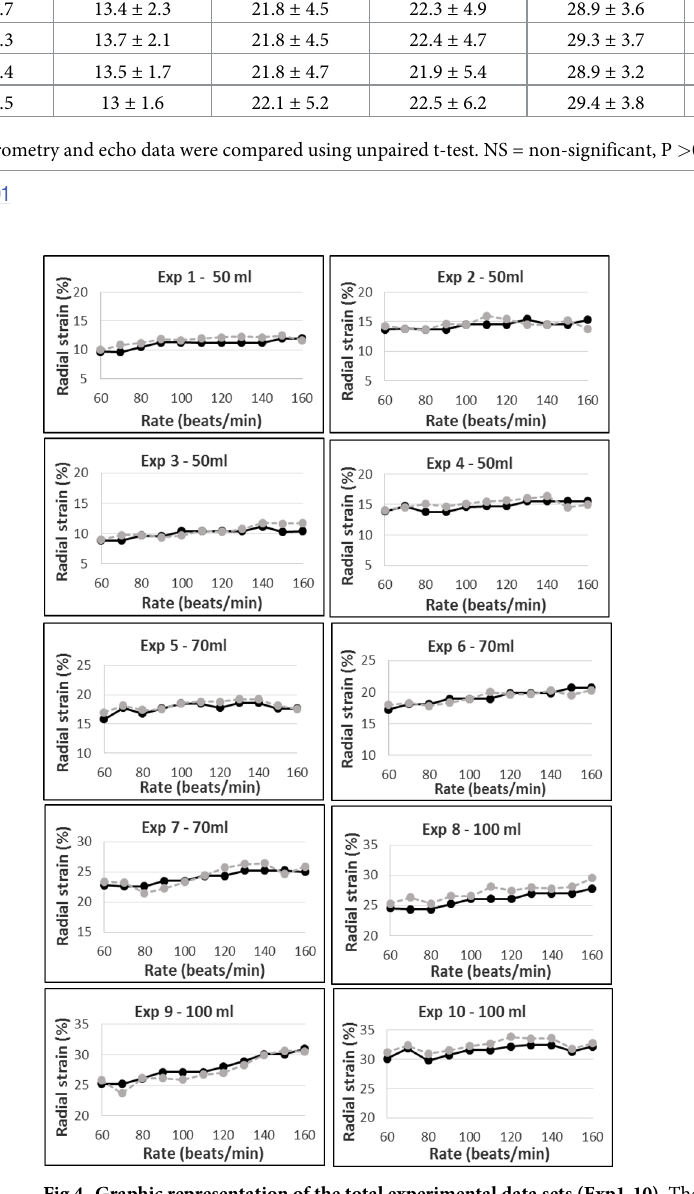
Fig 4. Graphic representation of the total experimental data sets (Exp1-10). These data were obtained from simultaneous measurements of the upper segment radial strain by sonomicrometers (black full lines) and by speckle tracking (grey dotted lines), recorded for each pump rate (from 60 to 160 beats/minute) at different pulsed volumes (4 sets for 50 ml/beat, 3 sets for 70 ml/beat and 3 sets for 100 ml/beat).